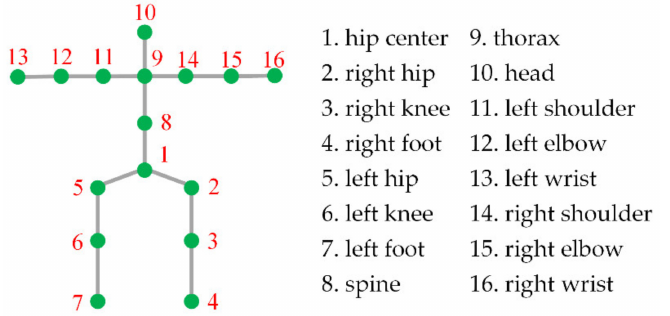
Figure 6. Distribution of human joint points.